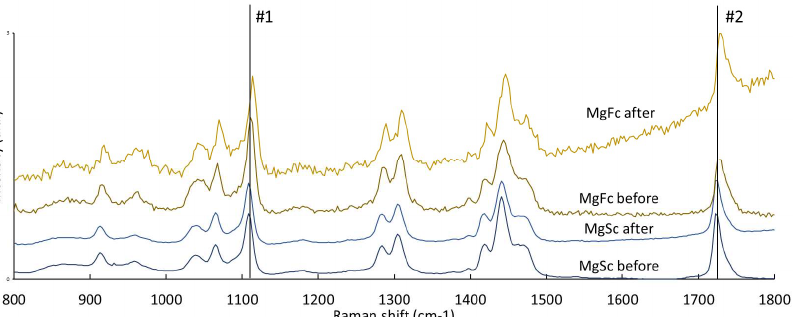
Figure 7. Raman spectra of the polymeric coatings on magnesium before and after immersion in rSBF for 9 days. Peaks for PCL are the C-COO stretch at 913 cm −1 and 958 cm −1 ; the C-C stretch at 1034 cm −1 , 1064 cm −1 , and 1110 cm −1 ; the CH2 -twist at 1284 cm −1 and 1304 cm −1 ; and the CH 2 -bend at 1418 cm −1 and 1441 cm −1 . Peaks in the spectra that indicate the crystallinity of the PCL are marked by #1 (1110 cm −1 ) and the C=O stretch at 1725 cm −1 (#2).